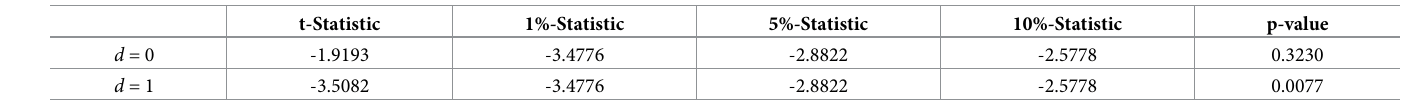
Table 1. ADF test of monthly incidence of hepatitis